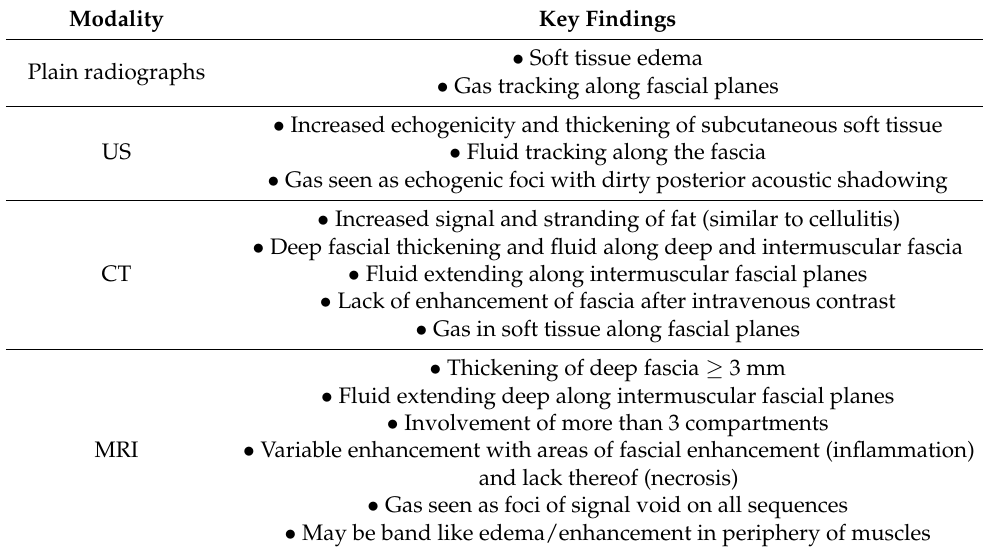
Table 1. Summary of imaging findings of necrotizing fasciitis.